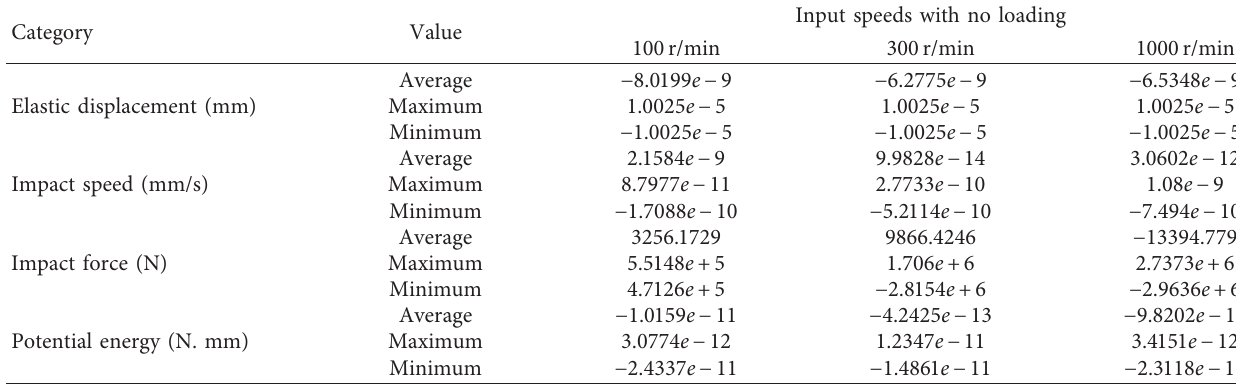
Figure 11: Impact potential energy of first-stage face gear pair with no loading. Table 1: Impact characteristics of first-stage face gear pair without